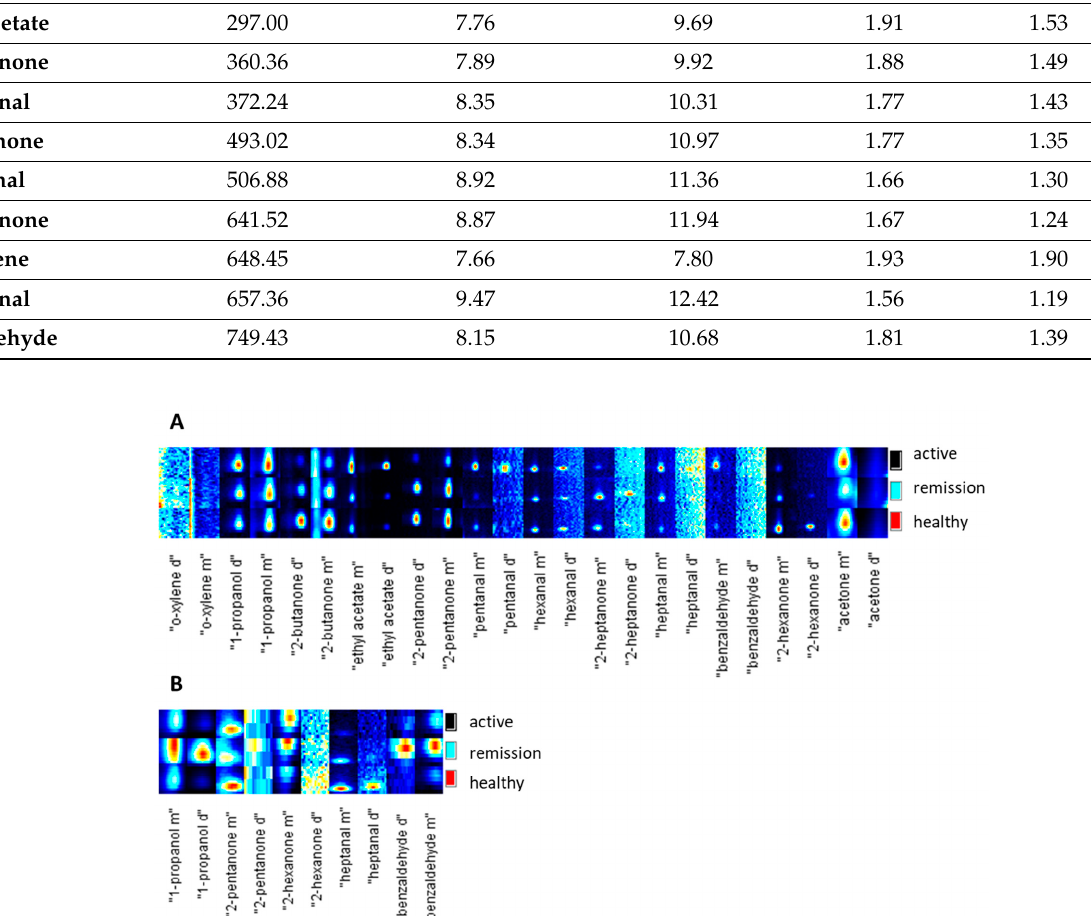
A total of 118 serum samples from 37 patients diagnosed with active IBD, 41 patients with IBD in remission, and 40 healthy IBD patients were analyzed. The spectral differ ‐ ences between each category can be seen in Supplementary Figure S2. The number of sig ‐ nals is higher than in the case of urine, with the richest area also being the initial spectrum part. For these samples, differentiation by visual inspection is complicated. Again, the spectra of the three categories are very similar, but a higher intensity of markers is ob ‐ served between 230 and 300 s of measurement time in the remission serum samples. To further investigate the spectra, the identification of the detectable VOCs by HS ‐ GC ‐ IMS in the analyzed serum samples was carried out. To this end, as was conducted with the urine samples, a tentative identification was performed by means of VOCal soft ‐ ware, and 15 compounds were identified. For confirmation of identification, a separate analysis of the 10 available standards was carried out. These are benzaldehyde, linalool, limonene, 2 ‐ heptanone, toluene, 2 ‐ hexanone, hexanal, 2 ‐ pentanone, 1 ‐ propanol, and heptanal. Individual and mixed standards of the above compounds were prepared at 10 μ g mL − 1 in commercial serum alkaline solution. Thus, six of the ten available compounds were separated, monitored, and identified using the proposed HS ‐ GC ‐ IMS method, as shown in Figure 3B. The retention and drift times, together with the reduced mobility constant ( K 0 ) of each identified compound, are shown in Table 2. The proton ‐ bound dimer and protonated monomer were detected for all compounds. Figure 4B shows the differences between IBD samples, comparing the proton ‐ bound dimer and protonated monomer signals between them. Visual examination of this figure reveals that compounds 1 ‐ propanol and benzaldehyde mainly appear in in ‐ dividuals in remission stage IBD, while the opposite occurs with 2 ‐ pentanone. Healthy IBD patients showed the highest concentration of heptanal, while diseased patients had the lowest content. On the other hand, the opposite is observed for 2 ‐ hexanone, with a higher concentration in diseased patients compared to patients without IBD.